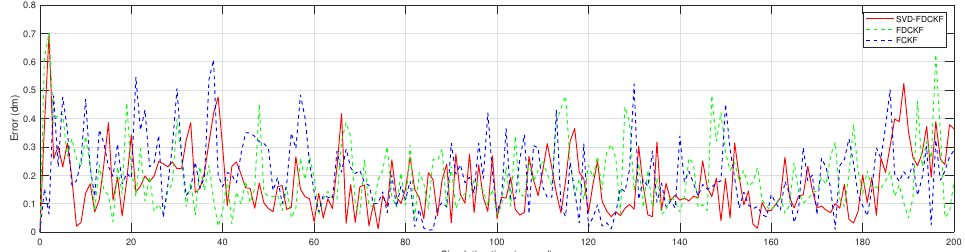
Figure 7. The error between the positioning result estimated by FCKF, FDCKF, SVD-FDCKF, and the actual position.